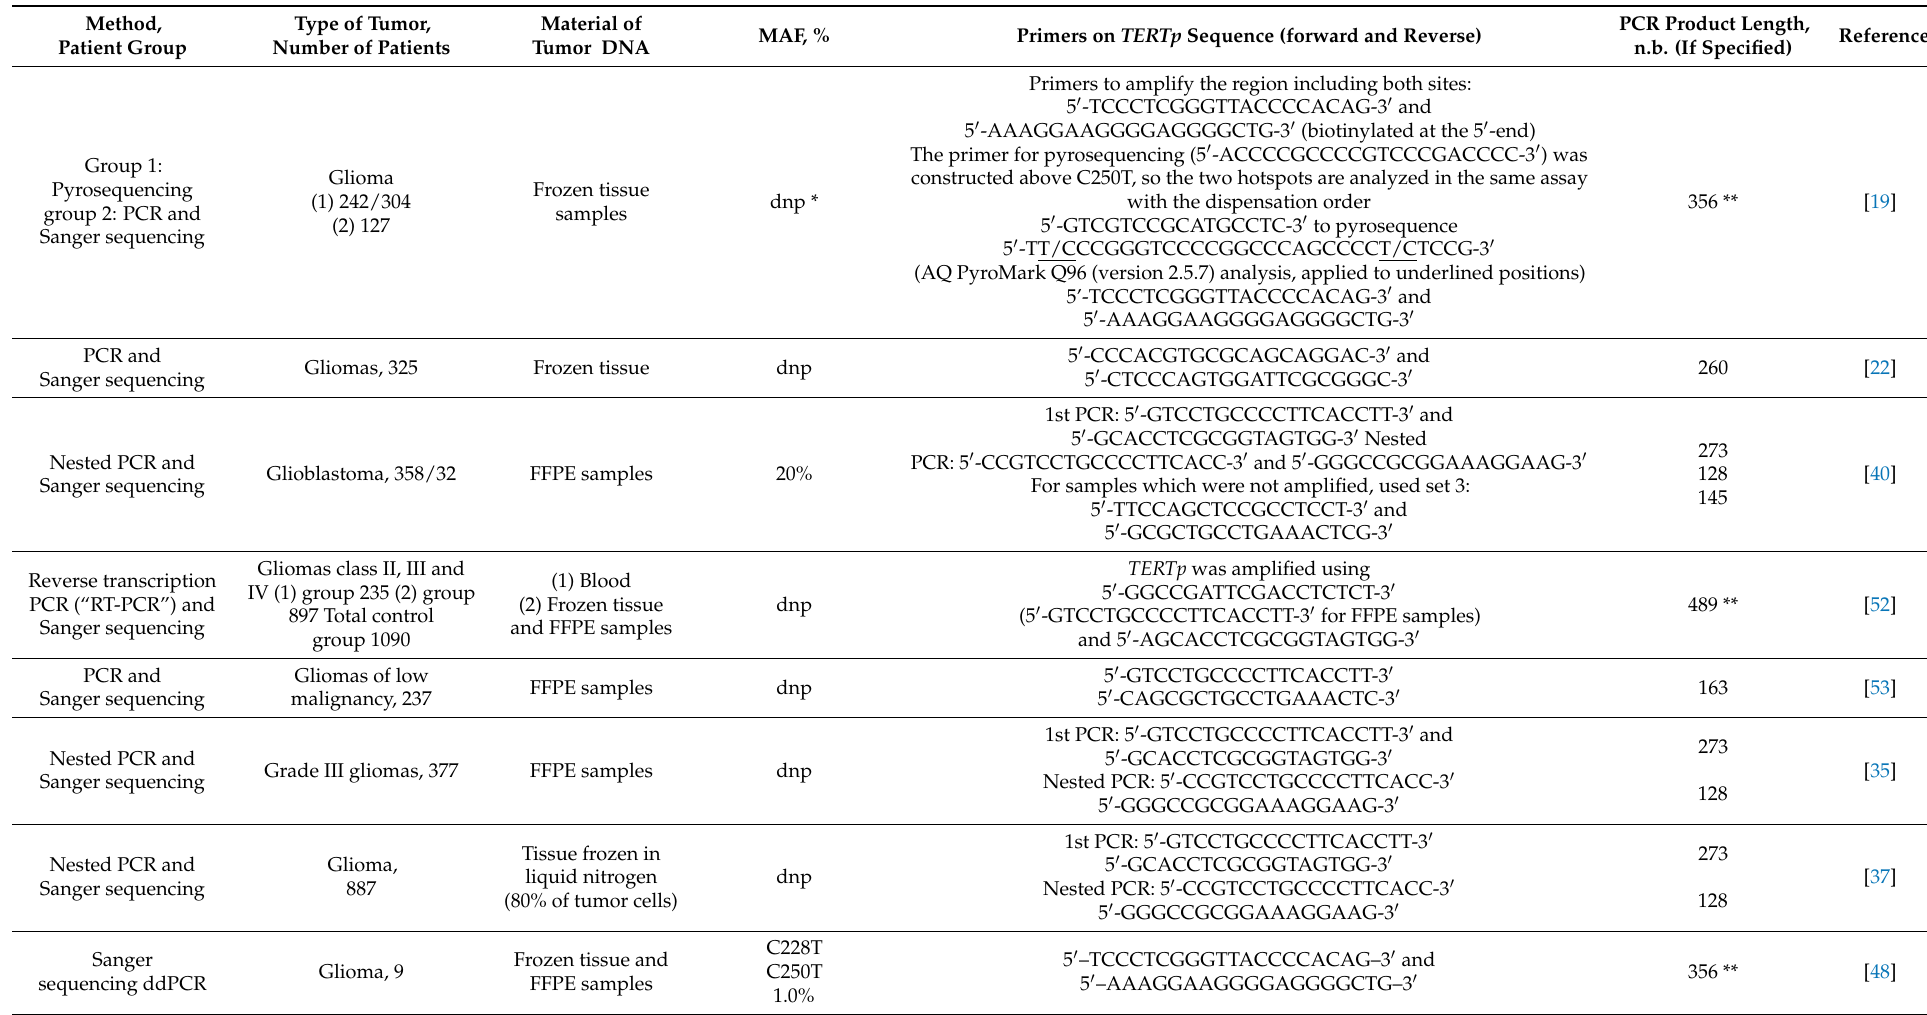
Table 2. Accuracy and methodological characteristics of tests to detect TERTp -mut in CNS tumor